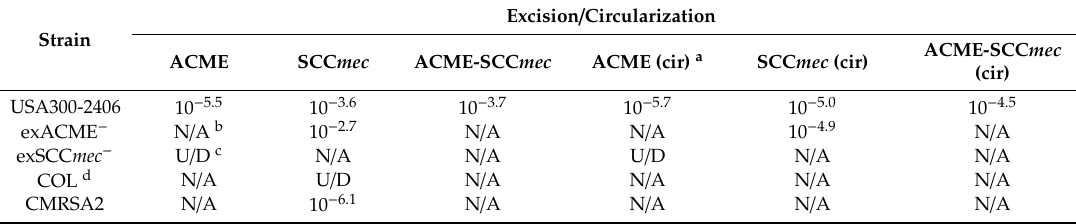
Table 3. Spontaneous excision frequency of ACME and / or SCC mec from the chromosome of S. aureus. Excision / Circularization Strain ACME-SCC mec ACME SCC mec ACME-SCC mec ACME (cir) a SCC mec (cir) (cir) USA300-2406 10 − 5.5 10 − 3.6 10 − 3.7 10 − 5.7 10 − 5.0 10 − 4.5 exACME − N / A b 10 − 2.7 N / A N / A 10 − 4.9 N / A exSCC mec − U / D c N / A N / A U / D N / A N / A COL d N / A N / A N / A CMRSA2 N / A 10 − 6.1 N / A N / A N / A N / A a cir indicated ACME and / or SCC mec formed circularized DNA after excision from the chromosome; b N / A, not applicable; c U / D, undetectable; d spontaneous excision of SCC mec was also tested in other MRSA strains, including COL and CMRSA2, as